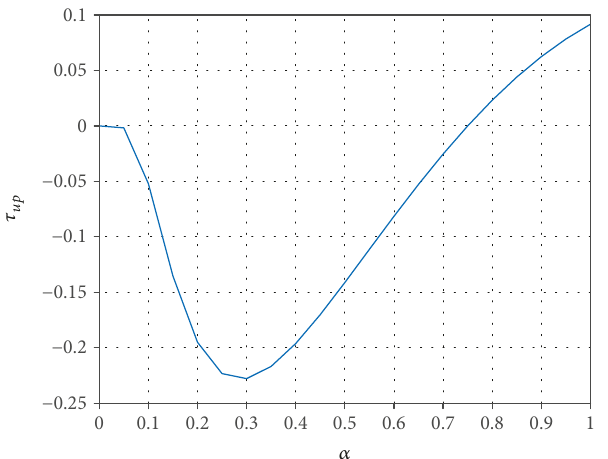
α when γ = 0 1 in case up and